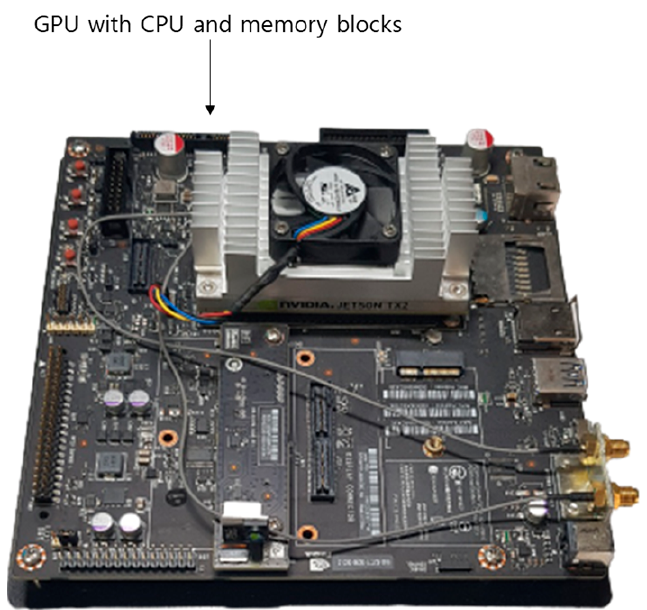
Figure 20. Jetson TX2 embedded system. Table 13. Comparisons of processing speed by proposed method on desktop computer and embedded system (unit: ms).